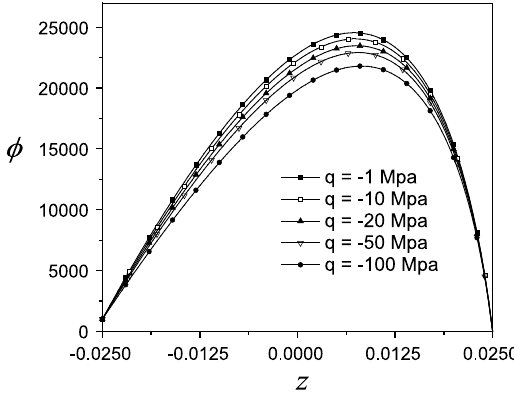
Fig. 9. Distribution of the electric potential φ along z -axis for the clamped supported FGPM cylindrical shell imposed by different mechanical loads ( T 1 = 200 , T 2 = 0 , a = 1 m, L = 4 m, a/h = 20 , φ 1 = 1000 , φ 2 = 0